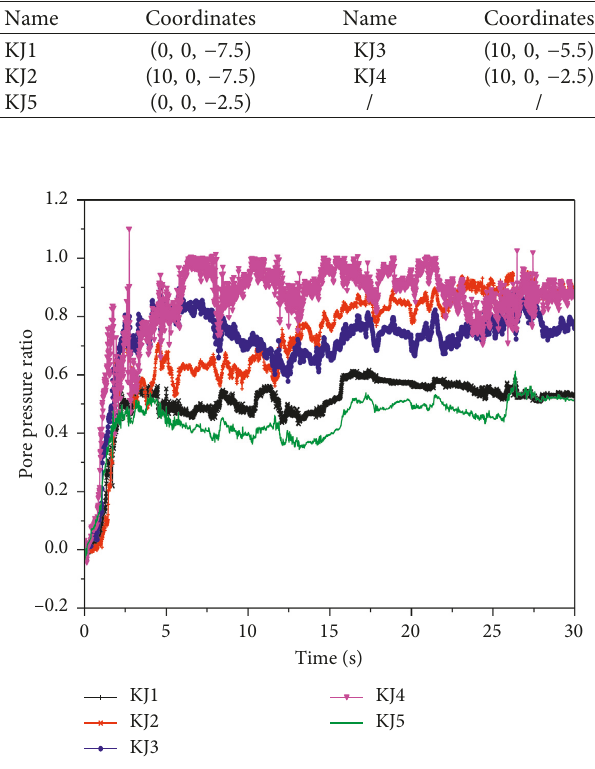
Figure 7: Time-history curves of the pore pressure ratio.